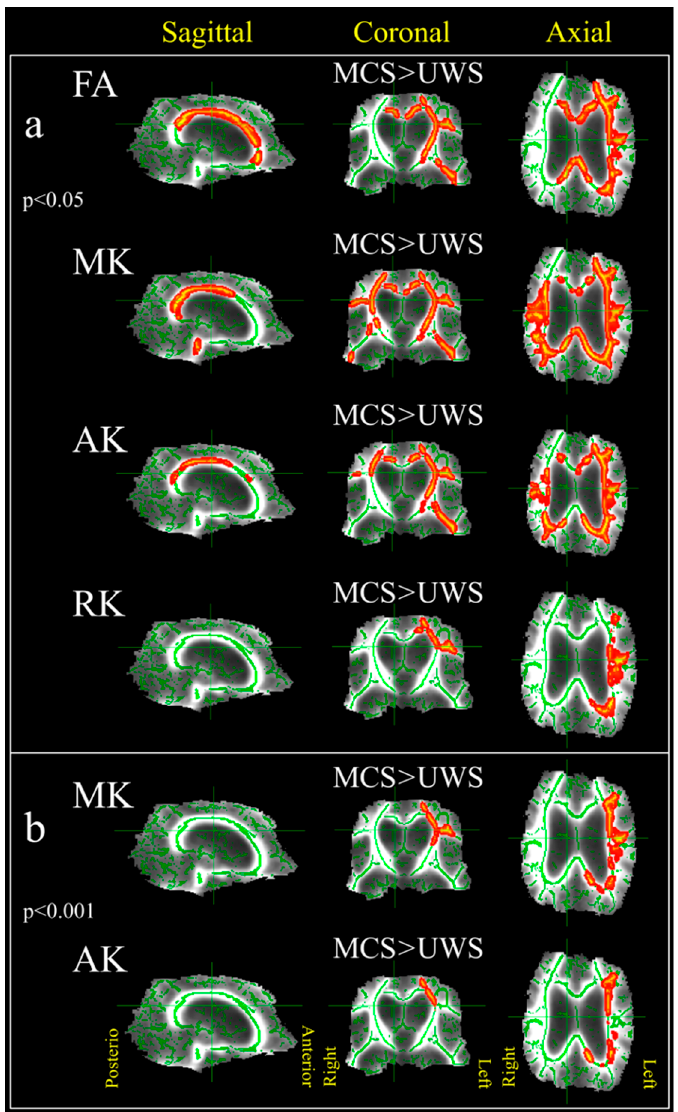
Figure 6. TBSS results demonstrating locations of diffusion metric changes in vegetative state/unresponsive wakefulness syndrome (VS/UWS) versus MCS patients. The analysed white matter skeleton is shown in green with the colour overlay of significant differences. Yellow/red colour scheme represents the areas where the diffusion metrics of MCS patients were significantly higher than VS/UWS. ( a ) the significance level, p < 0.05, ( b ) significance level, p < 0.001.